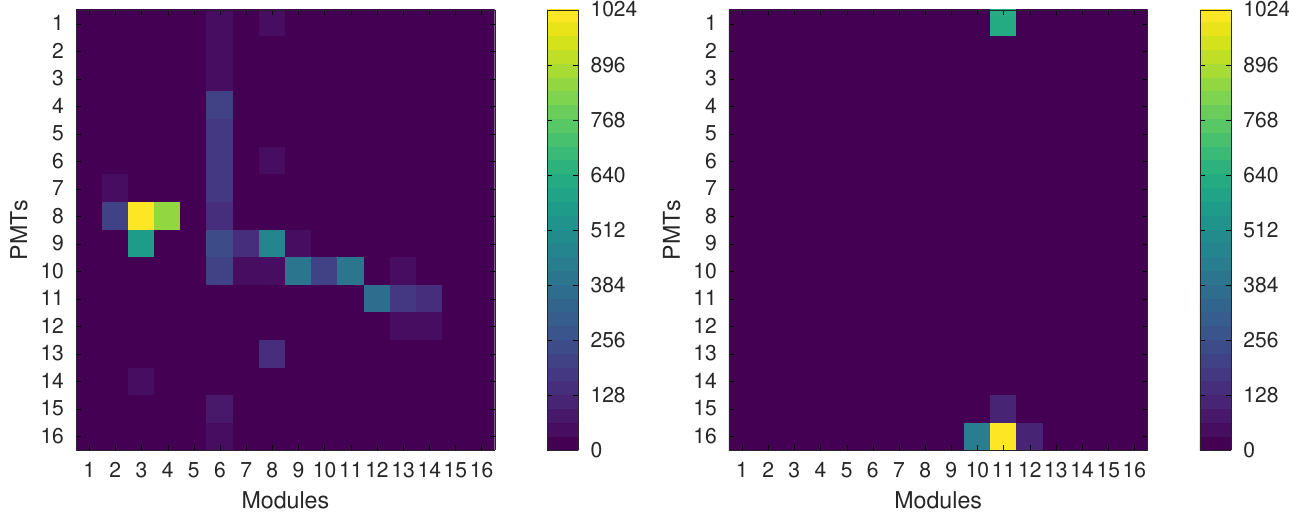
Figure 6. Left: an examples of an X-shaped trace consisting of a TLFs trace and a simultaneous crosstalk in module 6. Right: a short track at the bottom edge of the focal surface and a simultaneous signal on the other end of module 11 due to a feature of the electronics